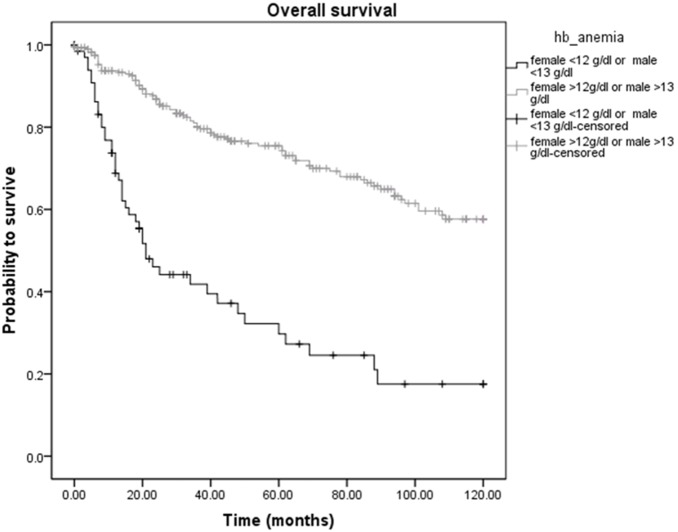
Kaplan-Meier curve for overall survival regarding high (≥13 g/dl in males and ≥12 g/dl in females) versus low (<13 g/dl in males and <12 g/dl in females) hemoglobin levels (p<0.001).